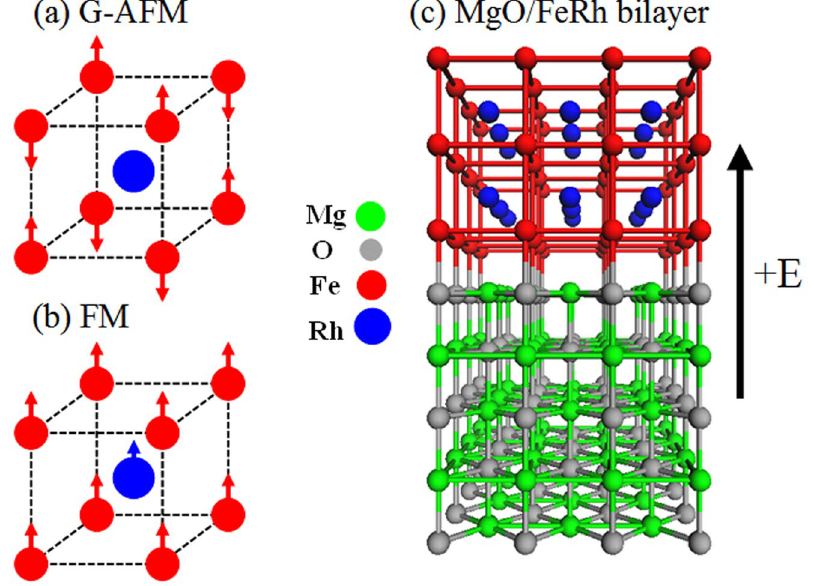
Figure 1. Magnetic structures of the ( a ) G-AFM and ( b ) FM phases of bulk FeRh. In the G-AFM structure the Fe atoms have staggered local moments of ~ ± 3.2 μ B which align antiferromagnetically between nearest- neighbor Fe atoms while the Rh has zero moment. In the FM phase the Rh moment is ~1 μ B . ( c ) The Fe- terminated interface and surface of the FeRh/MgO bilayer structure. Also we show the positive direction of the external electric